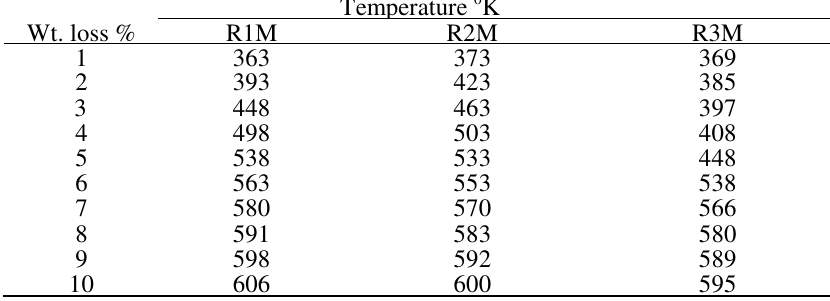
Figure 3. TG curve of epoxy acrylate with EOPA sample R Table 2. Temp. of 1-10 % loss in TGA (Program rate 10 0 C/min.) of cured epoxy acrylate resin of different acid values containing